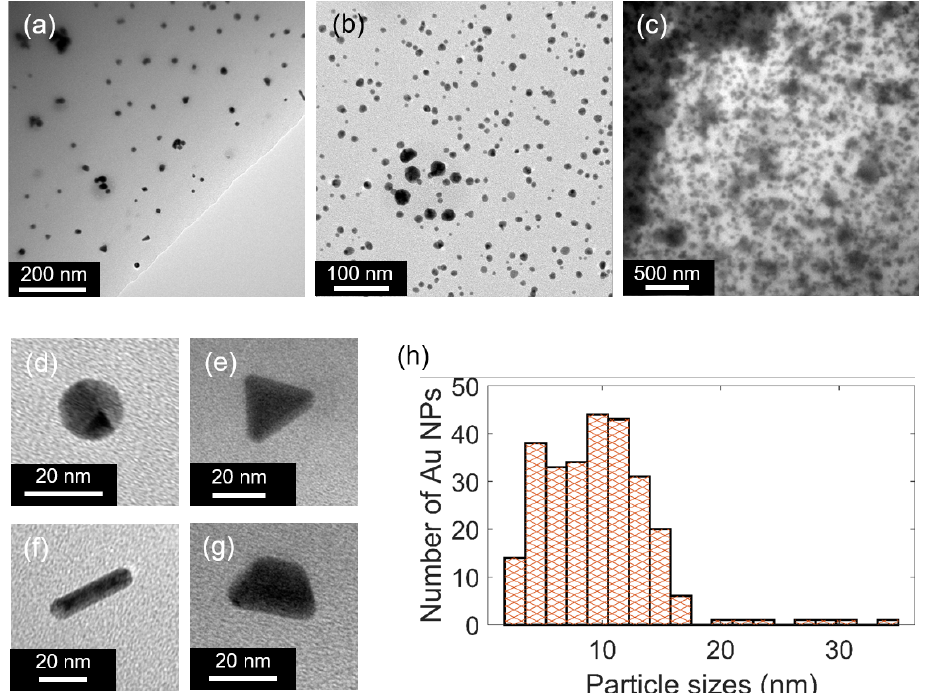
Figure 3. TEM images of the samples with different concentrations of Au salt: ( a ) 1 wt.%, ( b ) 3 wt.%, and ( c ) 7 wt.% after annealing at 95 ◦ C in 5 min. ( d – g ) The special shapes of generated Au NPs after thermal treatment. ( h ) The size distribution of Au NPs for 3 wt.% Au